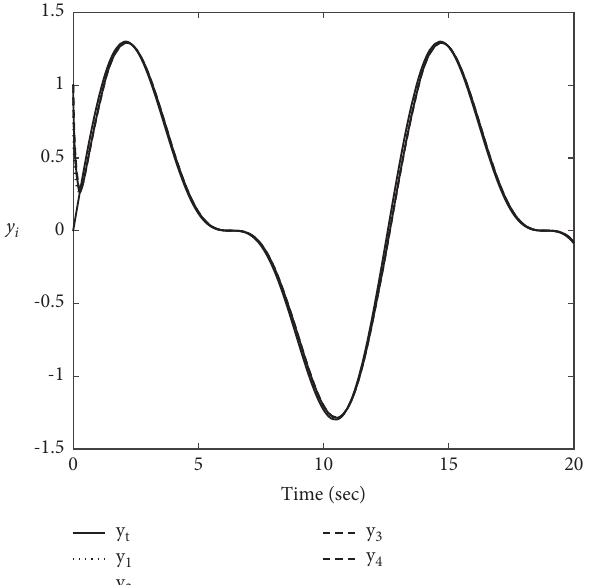
Figure 2: Trajectories of the leader and followers.